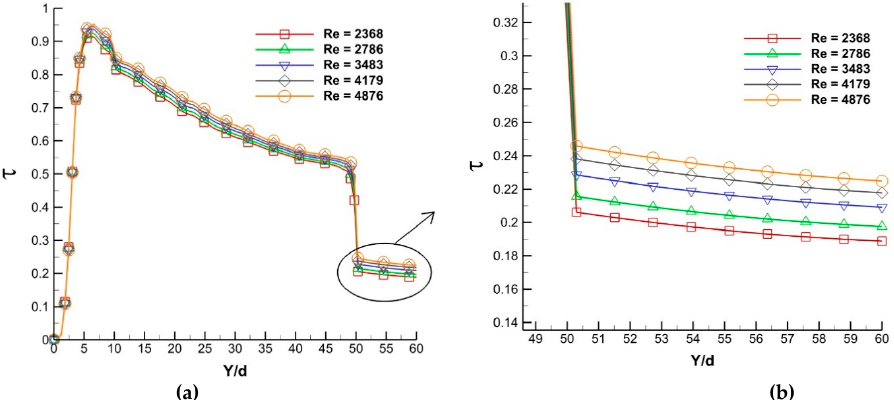
Figure 14. Effect of the Reynolds number on temperature distribution as a function of Y/d: ( a ) From the gas torch outlet to the steel plate; ( b ) enlarged part only for the steel plate thickness.